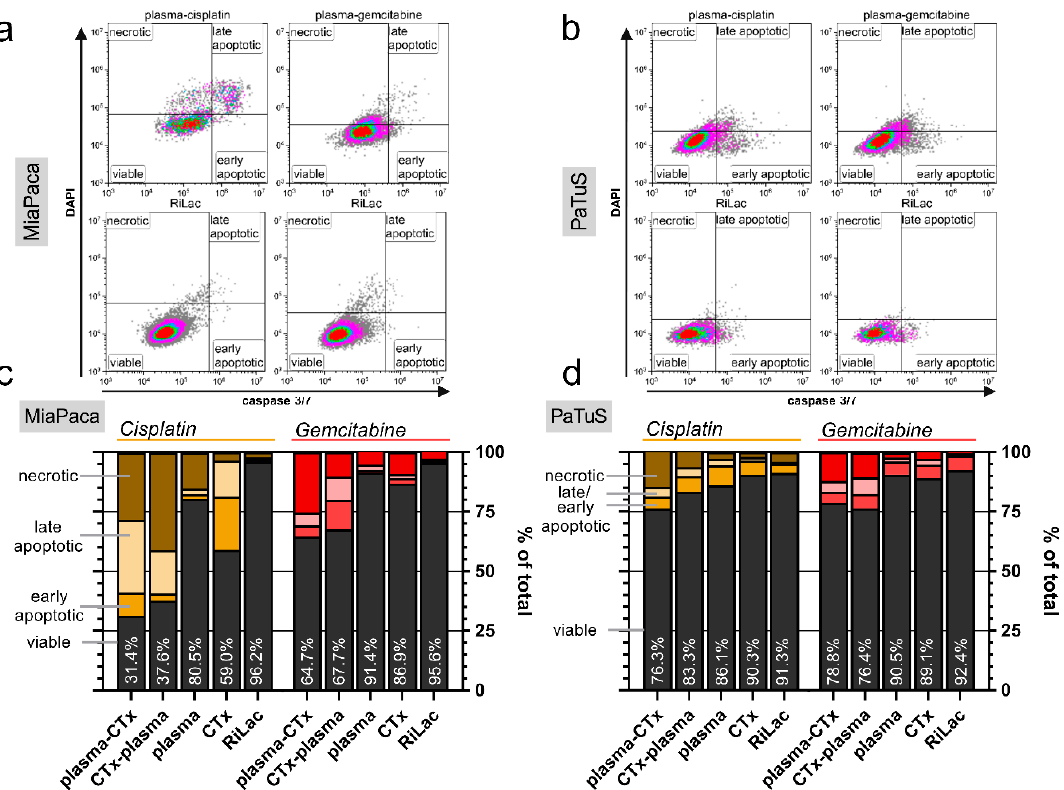
Figure 3. Combination of cisplatin and gemcitabine with physical plasma-conditioned Ringer’s lactate induced toxicity in pancreatic cancer cells. ( a , b ) representative gating of viable (DAPI - , caspase - ), early apoptotic (DAPI - , caspase + ), late apoptotic (DAPI + , caspase + ) and necrotic (DAPI + , caspase - ) MiaPaca ( a ) or PaTuS ( b ) cells at 48 h after exposure to plasma-CTx, CTx-plasma, or the corresponding Ringer’s lactate control (RiLac); ( c , d ) quantification of the percentage of viable, early and late apoptotic, or necrotic cells at 48 h for ( c ) MiaPaca and ( d ) PaTuS pancreatic cancer cells. Data are presented as mean and are representatives out of three independent experiments.